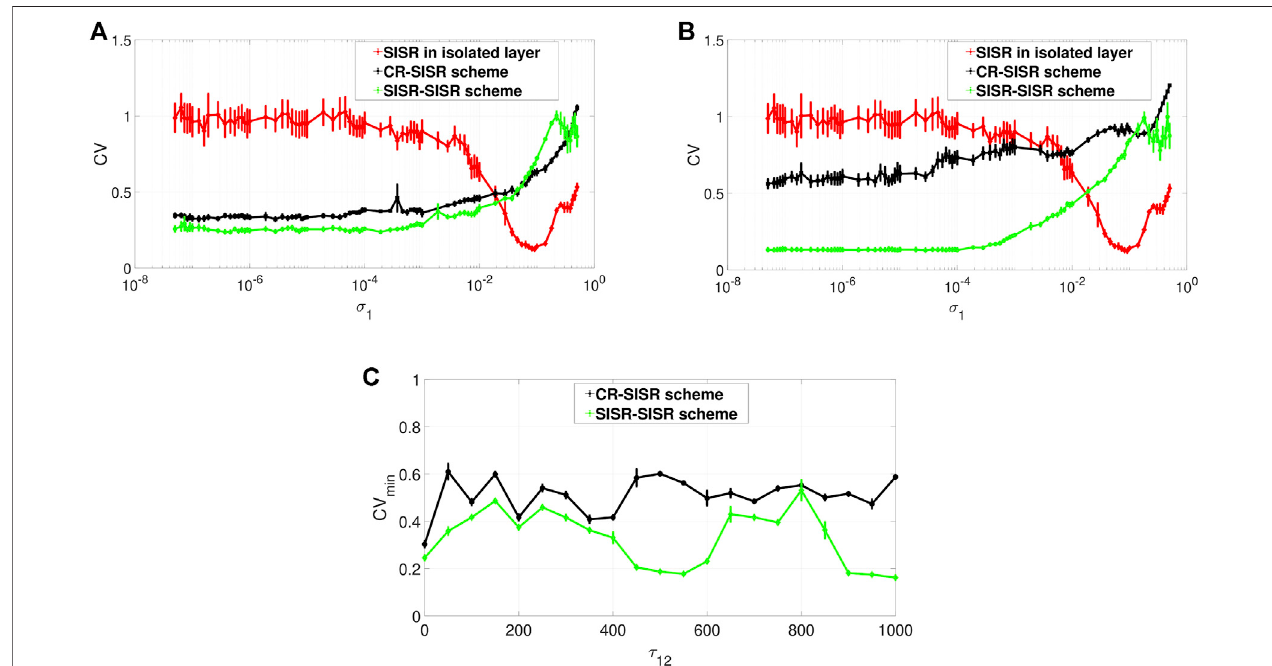
FIGURE 6 | Variation of CV of the controlled layer (exhibiting SISR) w.r.t. the noise intensity σ 1 and the inter-layer time delay τ 12 . Panels (A) and (B) show the CV curves in the absence ( τ 12 = 0) and presence ( τ 12 = 1,000) of the inter-layer time delay τ 12 , respectively. The red curves represent the variation in the degree of SISR in layer1wheninisolation.Theblack andthegreencurves showtheenhancementperformances oftheCR-SISR andSISR-SISR schemes,respectively. Panel (C) shows that for the same value of the inter-layer time delay, the SISR-SISR scheme always outperforms the CR-SISR scheme. Parameters of layer 2 in the CR-SISR scheme: ^ σ 1 (cid:1) σ 2 (cid:1) 0, ^ σ 2 (cid:1) σ 1 ≠ 0, ε 2 = 0.01, 〈 s 2 〉 = 2, β 2 = 0.1, τ 2 = 1, P 2 = 0.1, τ 2 d = 20. Parameters of layer 2 in the SISR-SISR scheme: ^ σ 2 (cid:1) σ 2 (cid:1) 0, ^ σ 1 (cid:1) σ 1 ≠ 0, ε 2 = 0.001, 〈